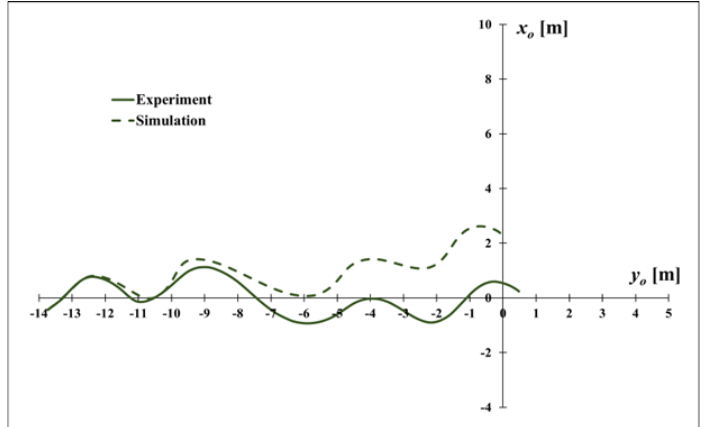
Figure 19. Comparison of experiment and simulation when the initial heading angle is 90 degrees.